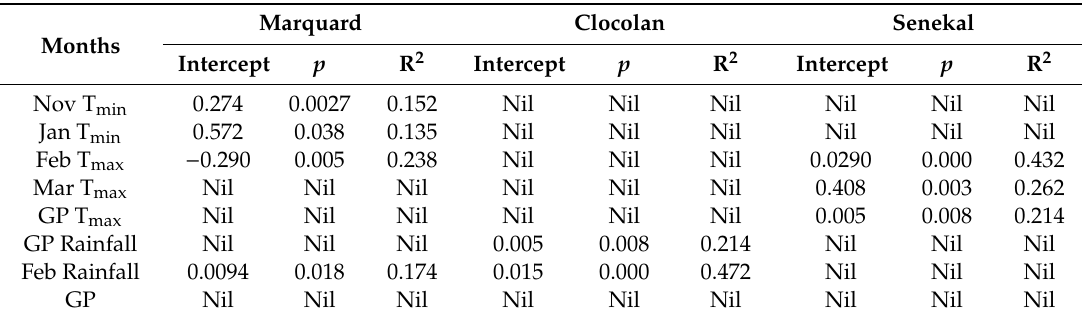
Table 10. A summary of regression results between detrended maize yield and the climatic (T min , T max and Rainfall) anomalies. Note: p = p -value at 0.05.